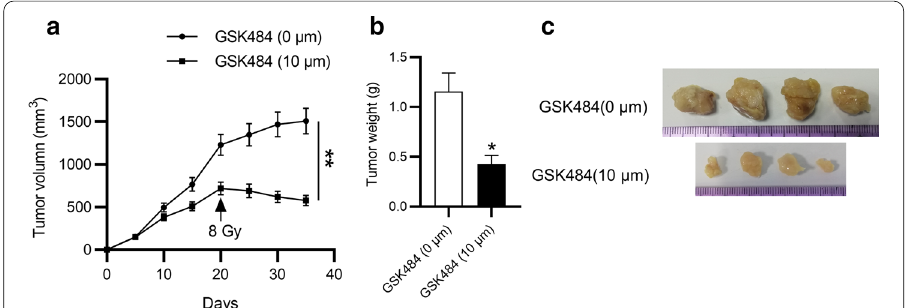
Fig. 5 GSK484 inhibits tumor growth and reverses radioresistance in vivo. C666-1 cells treated with 10 µm GSK484 or 0 µm GSK484 were injected into mice, n 4, tumor growth curves ( a ), weights ( b ) and images ( c ). = Unpaired Student’s test. *p < 0.05, **p <